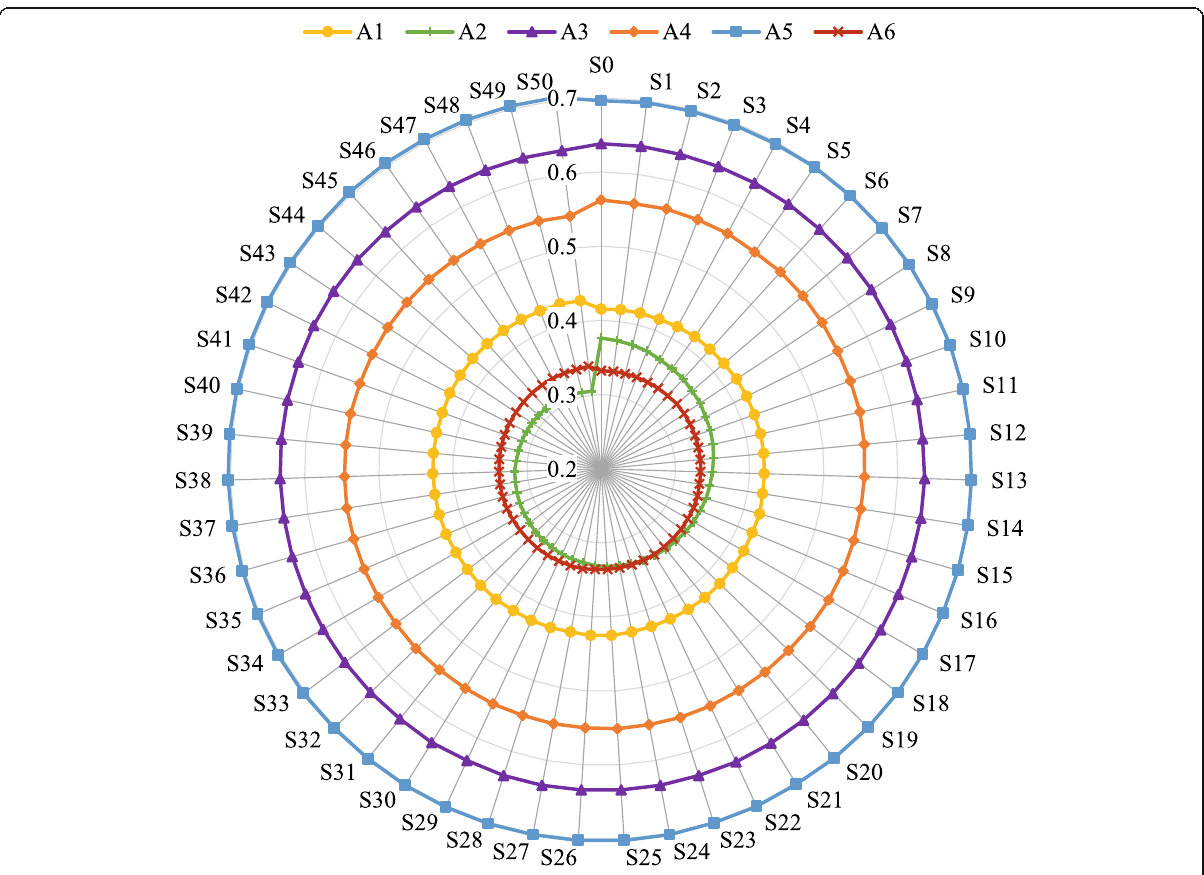
Fig. 9 The sensitivity analysis to changes in the criteria weights